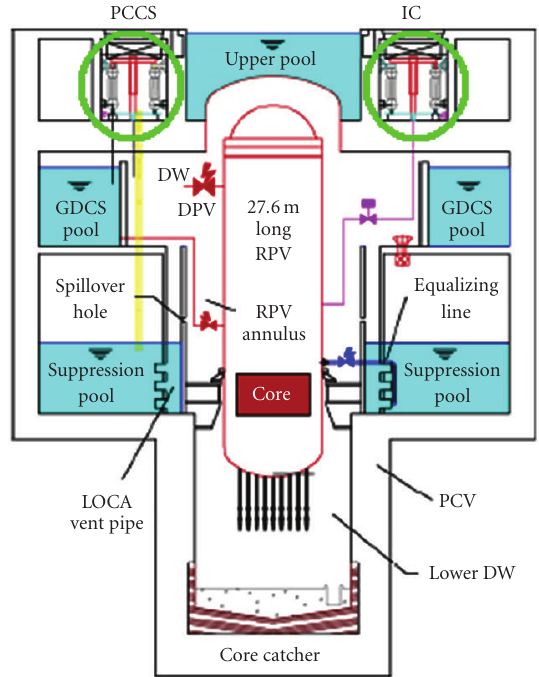
Figure 2: Isolation Condenser (IC) of the